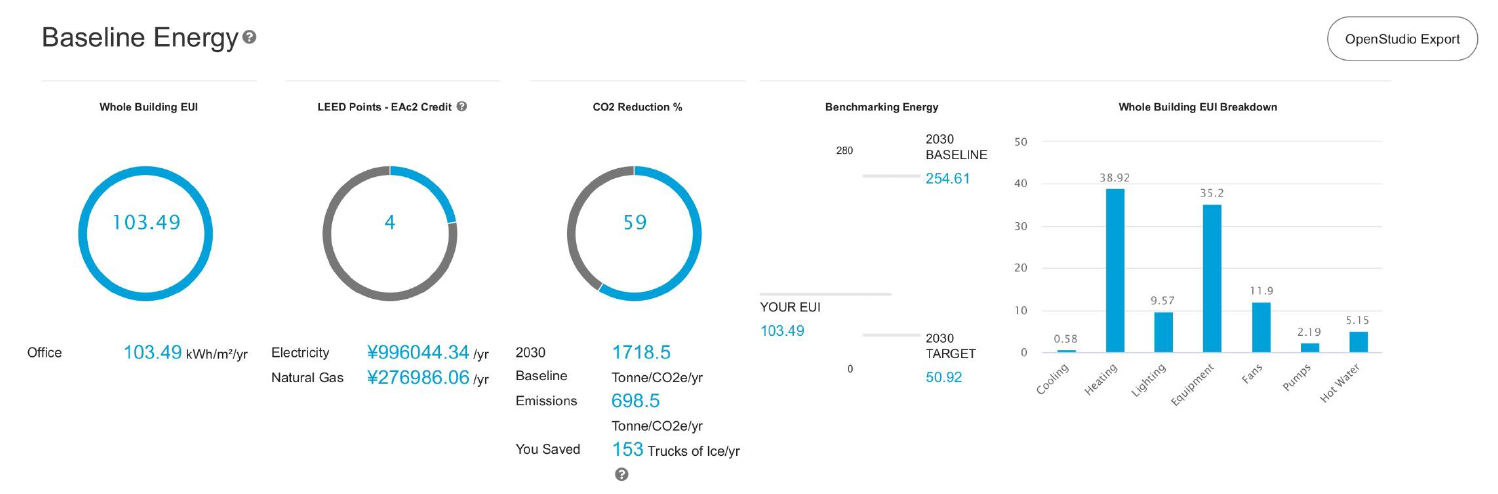
Clean Technol. 2022 , 4 , FOR PEER REVIEW Figure A11. Zone 3-C Kunming, Yunnan (post-COVID-19 78% scenario). Figure A11. Zone 3-C Kunming, Yunnan (post-COVID-19 78% scenario).